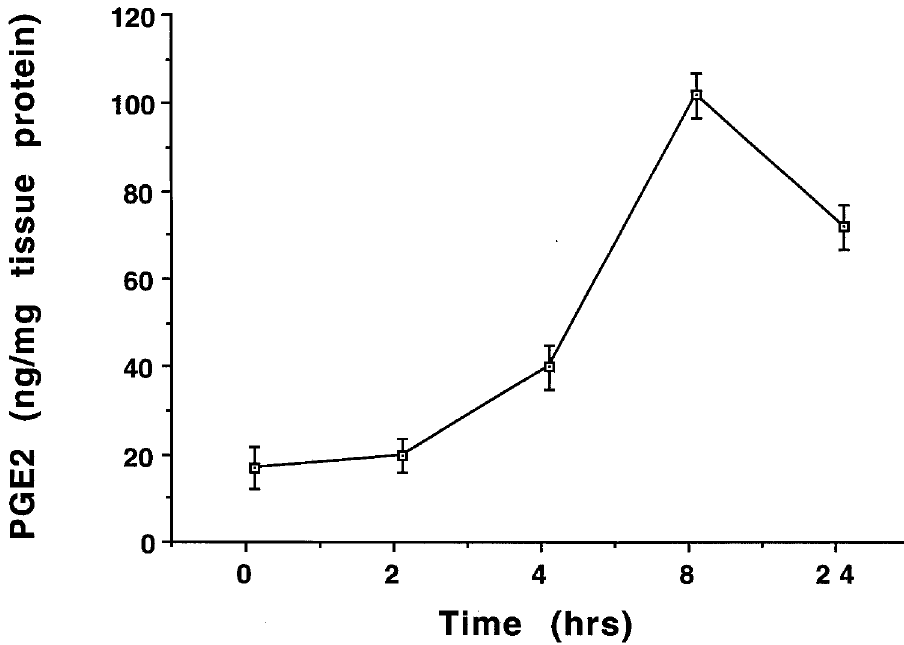
FIG. 3. Evaluation of IL-1 stimulated PGE 2 formation in HISM cells between 0–24h. HISM cells were exposed to 10 units/ml IL-1 b for the time periods indicated. Each point represents the mean±SEM of six values.